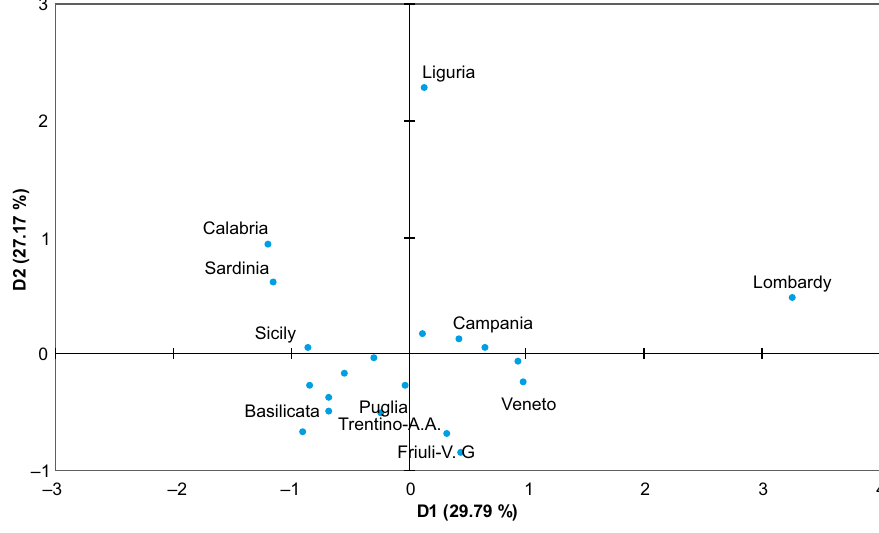
Fig. 3. Factor scores of NUTS2